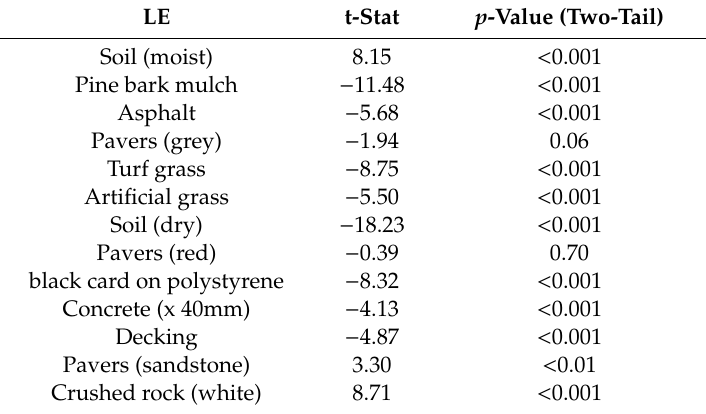
Table 6. Summer 2018 and summer 2019 DR data, two-sample t-test (assuming equal variances, α = 0.05). A negative t-Stat indicates the 2018 mean is less than the 2019 mean. The bold p -values indicate the means of these LEs are not statistically di ff erent. LE t-Stat p -Value (Two-Tail) Soil (moist) 8.15 < 0.001 Pine bark mulch − 11.48 < 0.001 Asphalt − 5.68 < 0.001 Pavers (grey) − 1.94 0.06 Turf grass − 8.75 < 0.001 Artificial grass − 5.50 < 0.001 Soil (dry) − 18.23 < 0.001 Pavers (red) − 0.39 0.70 black card on polystyrene − 8.32 < 0.001 Concrete (x 40mm) − 4.13 < 0.001 Decking − 4.87 < 0.001 Pavers (sandstone) 3.30 < 0.01 Crushed rock (white) 8.71 <